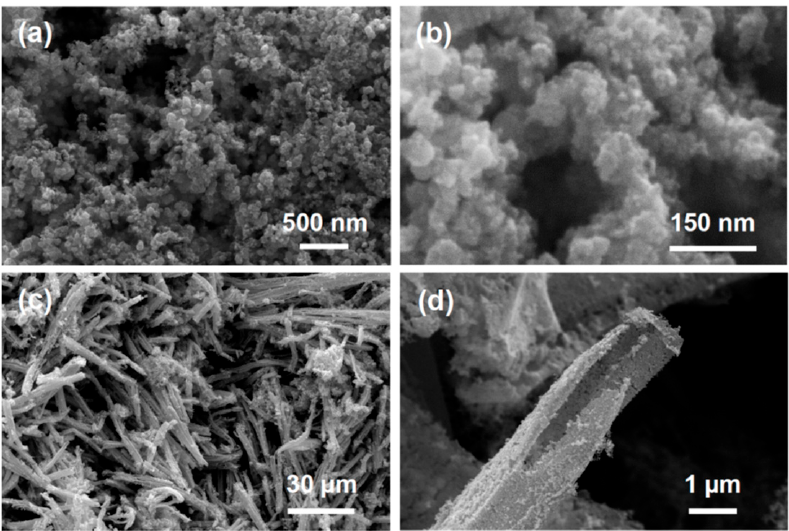
Figure 3. Scanning electron microscope images of ( a , b ) Au-Cu bi-metallic porous nanofoam; ( c , d ) Porous Au-Cu-Pd macrobeams.